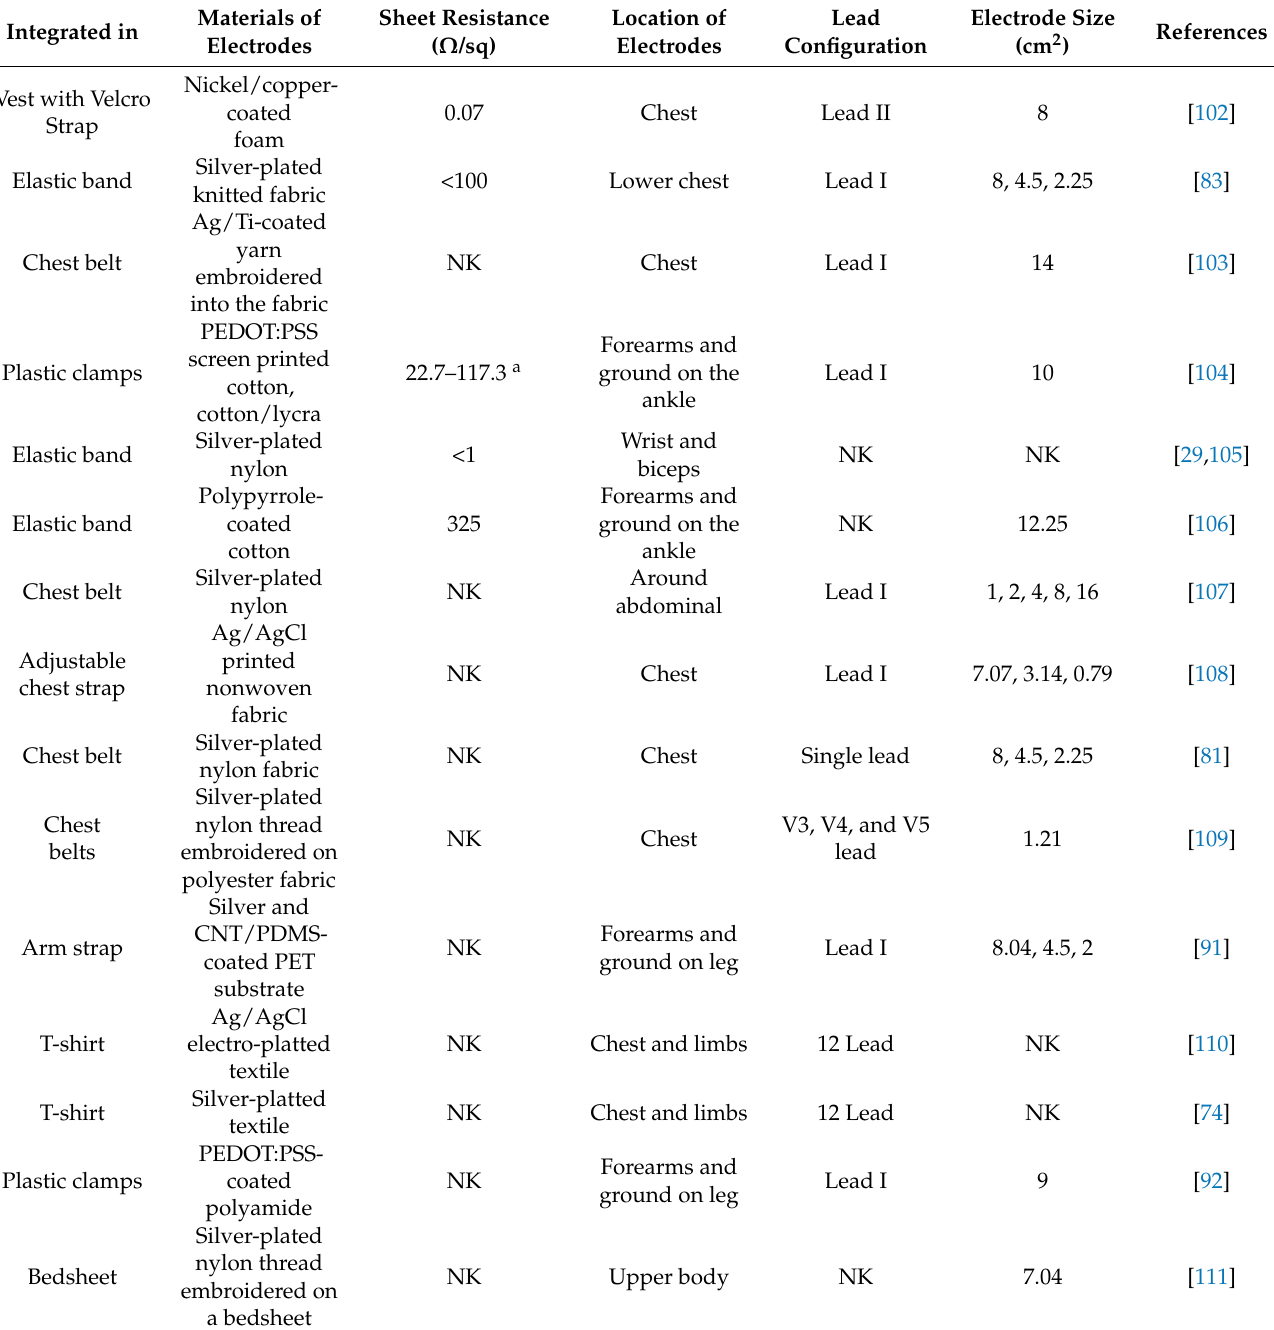
Table 2. Contact-based textile electrodes for ECG